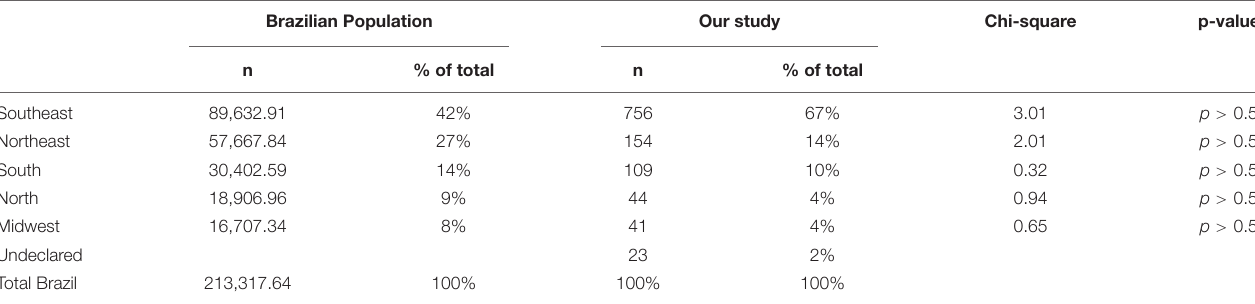
TABLE 4 | Population by region in Brazil (IBGE, 2021) and in our study (n and % of total for each). Brazilian